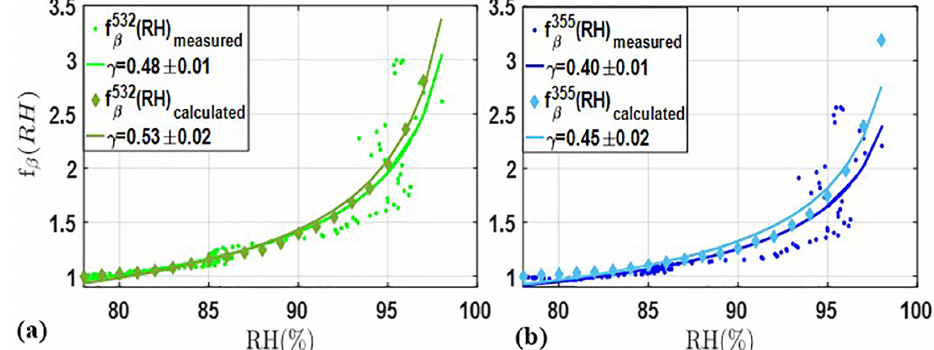
Figure 7. Humidograms calculated (a) at 532nm and (b) at 355nm, within the 1.5 to 2.4kma.s.l. aerosol layer from the RL + MWR measurements and calculated using Mie theory and measured chemical composition and size distribution at 2.5kma.s.l. RH ref =78% was used for both